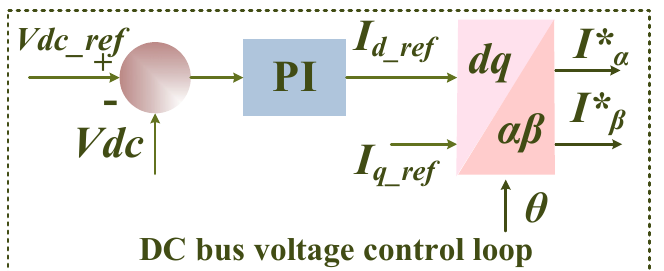
Figure 7. Loop for controlling the voltage on the dc bus.